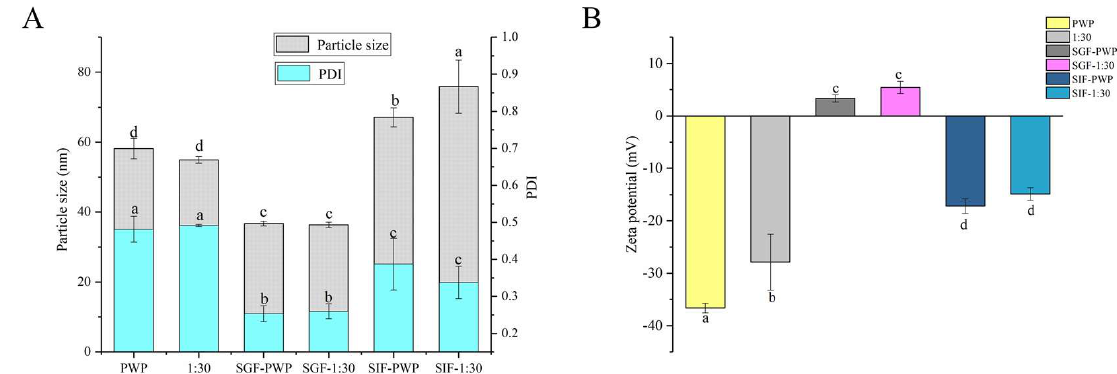
Figure 6. ( A ) Particle size, PDI and ( B ) zeta potential of PWP and PNS-PWP (1:30) before and after simulated gastrointestinal digestion. Different subscript letters indicate a significant difference ( p < 0.05).